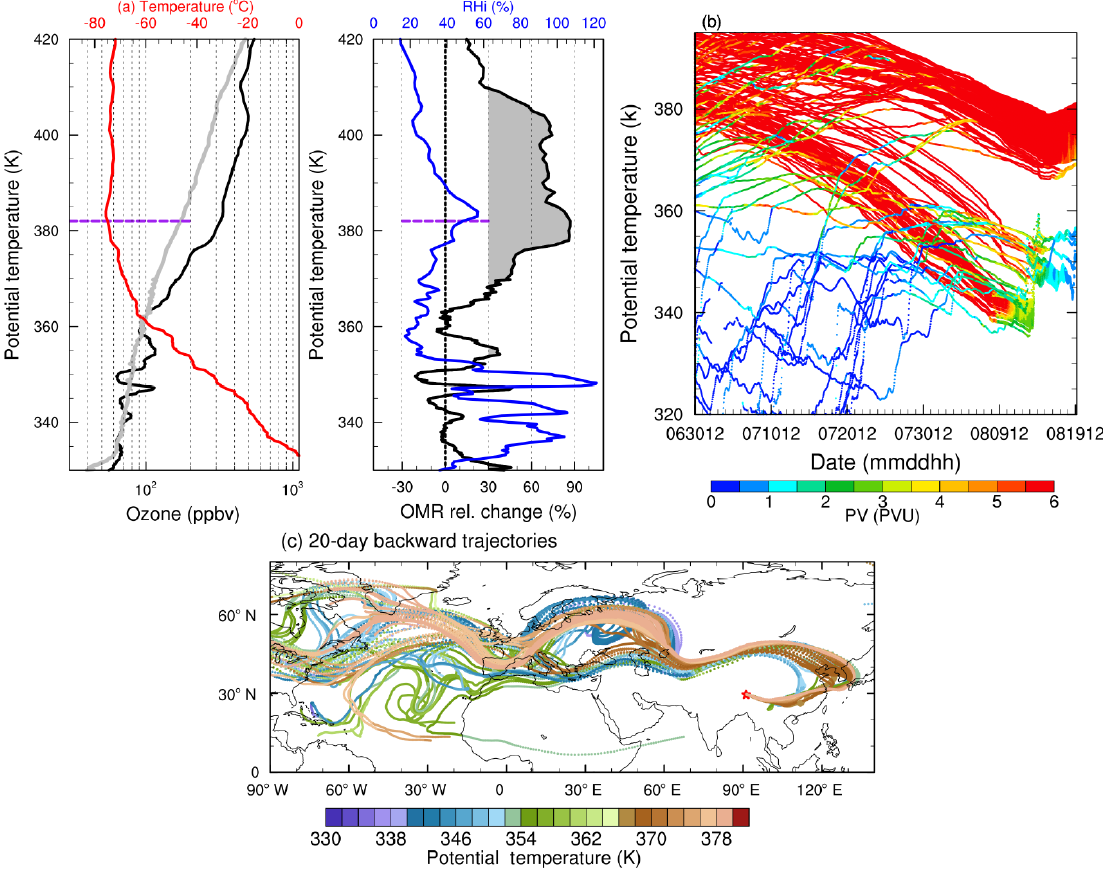
Figure 6. The same as Fig. 5, but on 19 August 2013.